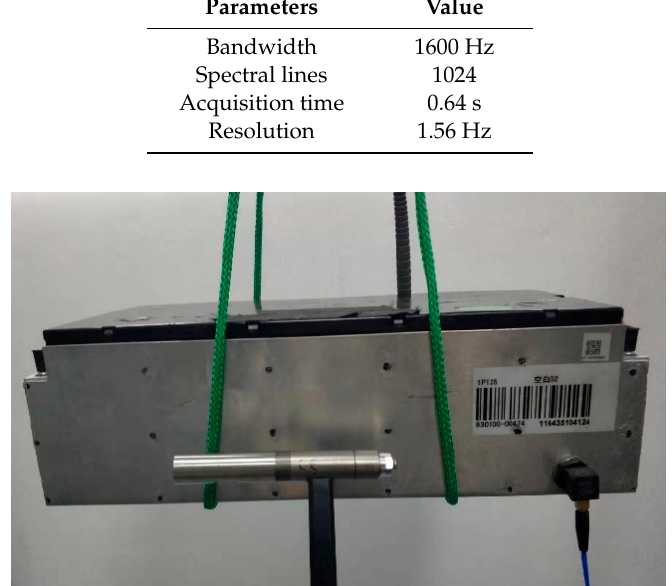
Figure 3. The impulse excitation experiment performed on a battery module. Table 2. The experimental parameters.